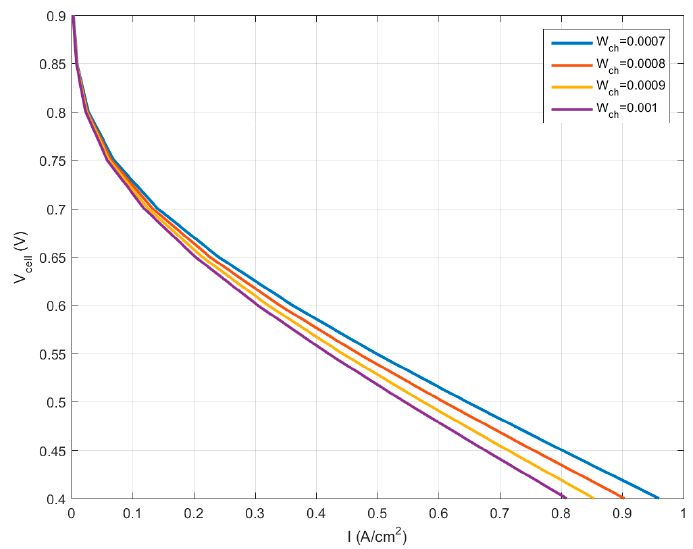
ff ect of channel width on the HT-PEMFC Figure 10. Effect of channel width on the HT-PEMFC performance. Figure 10. E